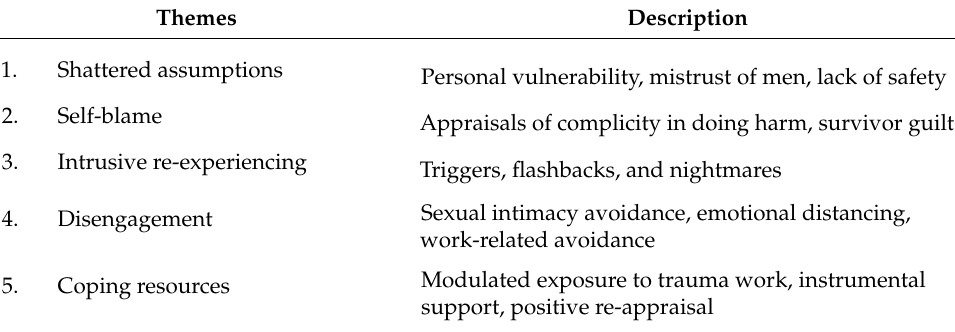
Table 1. Brief description of